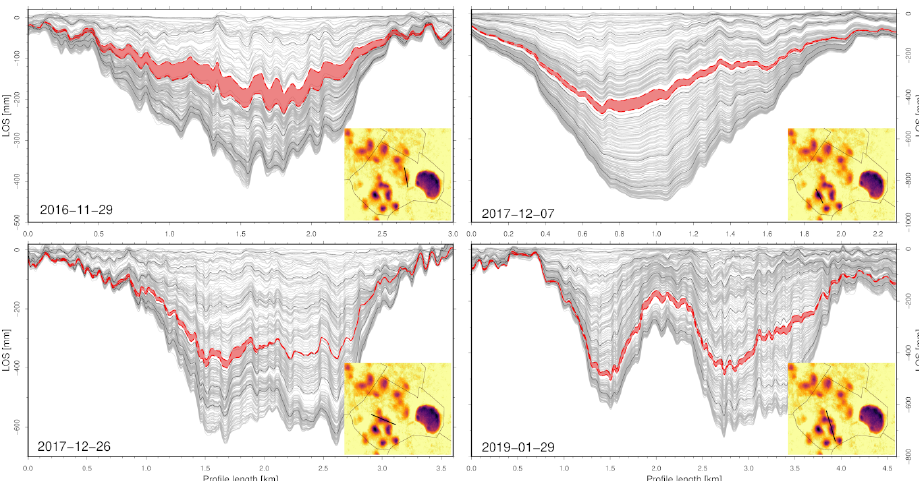
Figure 9. Line-of-Sight (LOS) displacements calculated based on the SBAS method. Successive curves correspond to 6 day increments of LOS displacements. In all cases, the calculated profiles cross the subsidence troughs in which permanent displacements after mining tremors from 2016, 2017 and 2019 were observed. The areas marked in red represent the size of the LOS displacement increases observed after the mining tremors occurred. The presented SBAS analysis covered a period from 15 November 2014 to 26 October